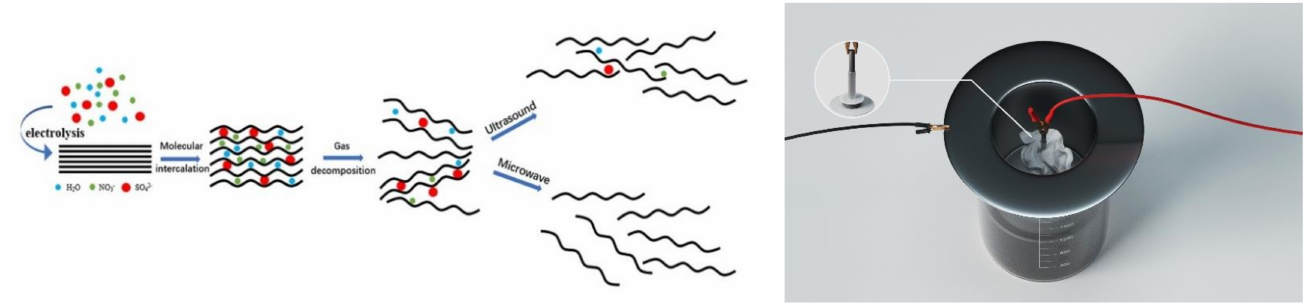
Figure 1. Electrolytic device and schematic diagram for electrochemical preparation of